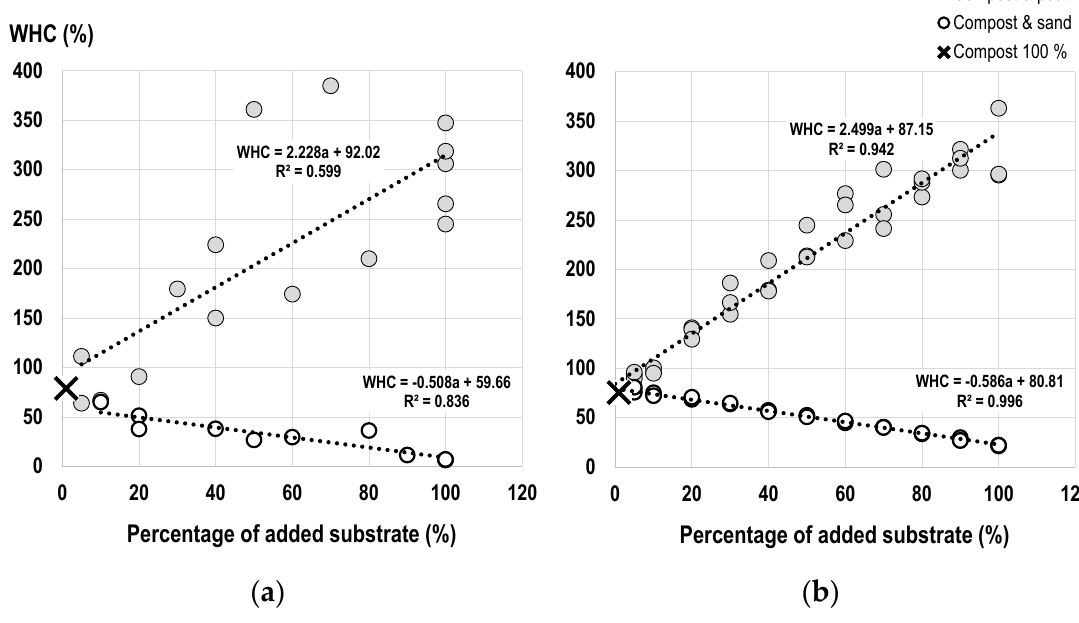
Figure 1. Interrelationship between the percentage of added sand and peat and the WHC of the substrate mixtures: ( a ) WHC determined according to the “droplet counting method” [10]. ( b ) WHC determined according to the “cylinder sand bath method” [19].